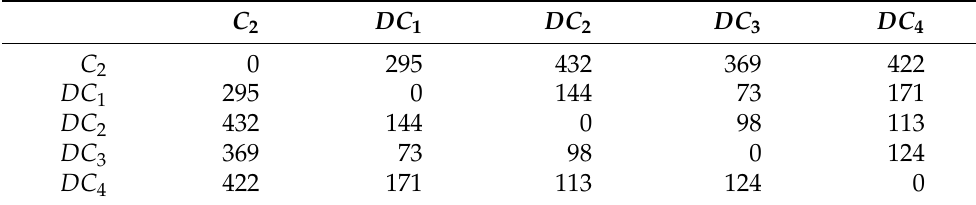
Table 8. Temporal distance between nodes [minute], referring to the second